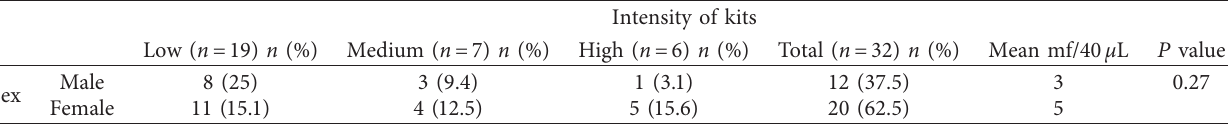
Table 5: Intensity of FTS kits of LF cases ( n � 32) with relative age and sex in Jeldu district, West Shoa, Ethiopia. Intensity of kits